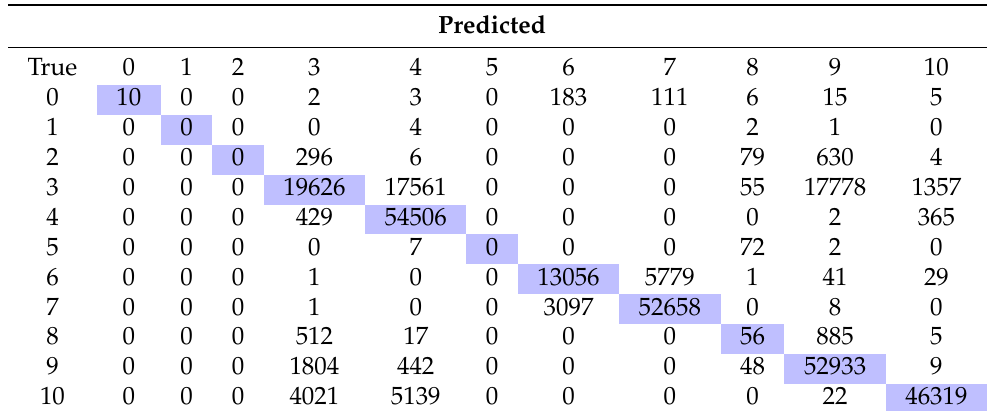
Table 44. SVM confusion matrix.